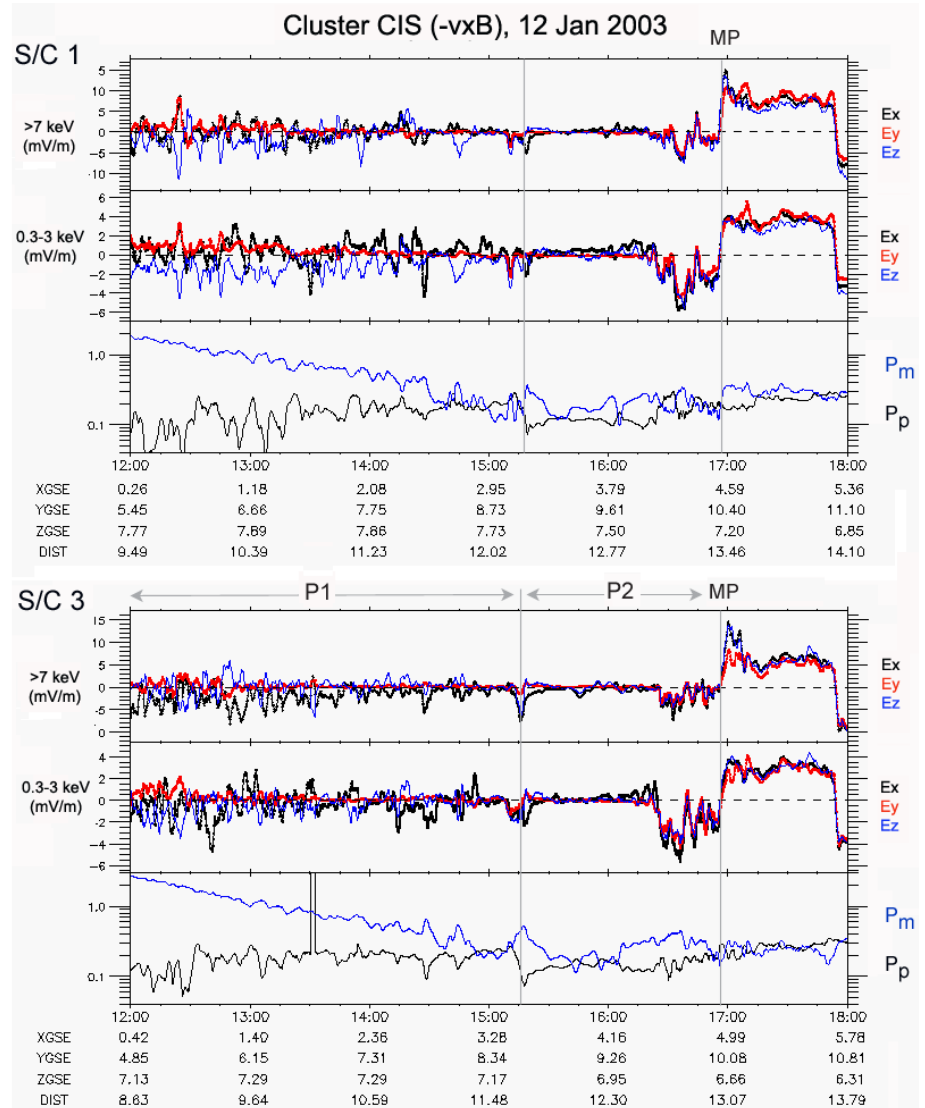
Fig. 3. − v × B and pressure for s/c 1 and s/c 3 on 12 January 2003. Top panels show − v × B in GSE coordinates for two energy intervals, > 7keV and 0.3–3keV. Bottom panel shows plasma pressure (Pp) and magnetic field pressure